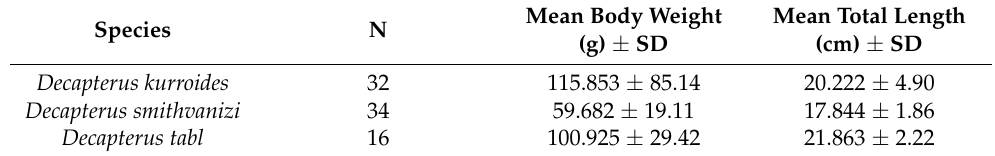
Figure 2. Map showing Panay Island and the location of fish markets in the province of Iloilo where fish samples were collected. Table 1. Summary of length and weight of redfin Decapterus from the Sulu Sea used in this study.